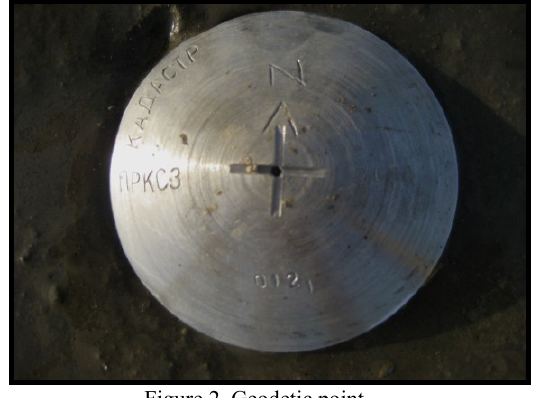
Figure 2. Geodetic